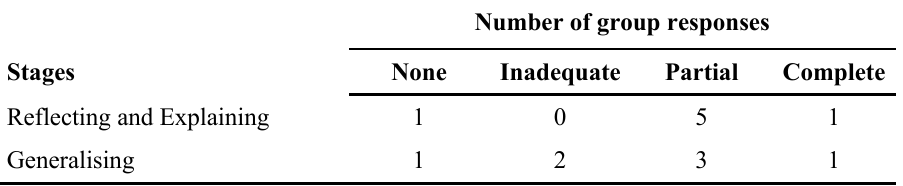
Table 1 : Results on group constructions for monotonically increasing (N = 7) Number of group responses Stages None Inadequate